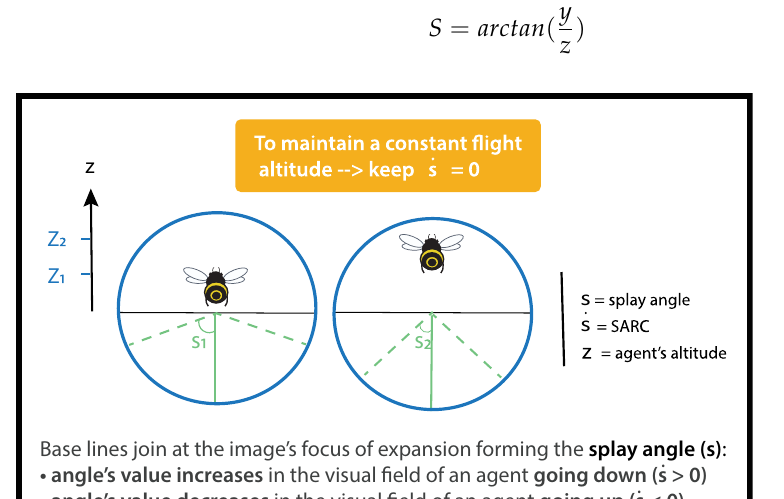
Figure 2. Splay angle and its rate of change